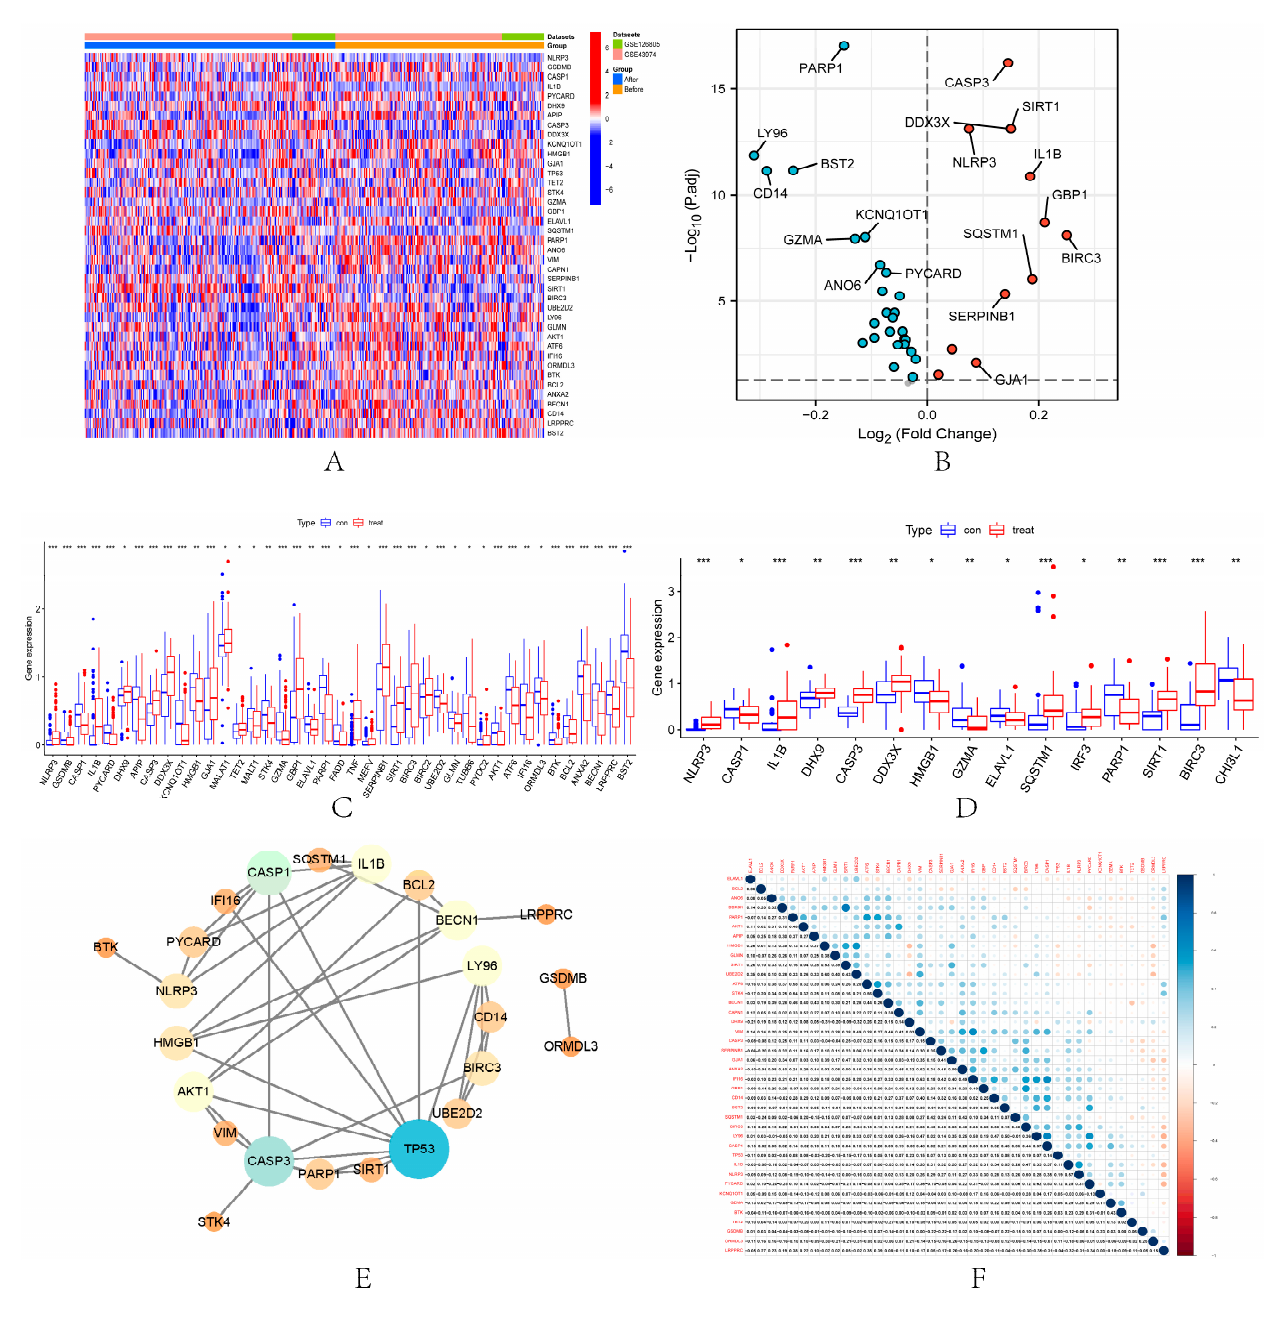
Figure 1. Identification of DEPRGs in IRI. Heatmap ( A ) and volcano map ( B ) of 40 DEPRGs in the combined dataset. Boxplots show the difference in DEPRGs expression before and after renal ischemia-reperfusion in GSE43974 ( C ) and GSE126805 ( D ). * p < 0.05, ** p < 0.01, the *** p < 0.001. ( E ) PPI networks of 40 DEPRGs in the combined dataset. ( F ) Correlation among 40 DEPRGs in the combined dataset. Positive correlations are shown in blue and negative correlations are in red. The color depth reflects the strength of the correlation.